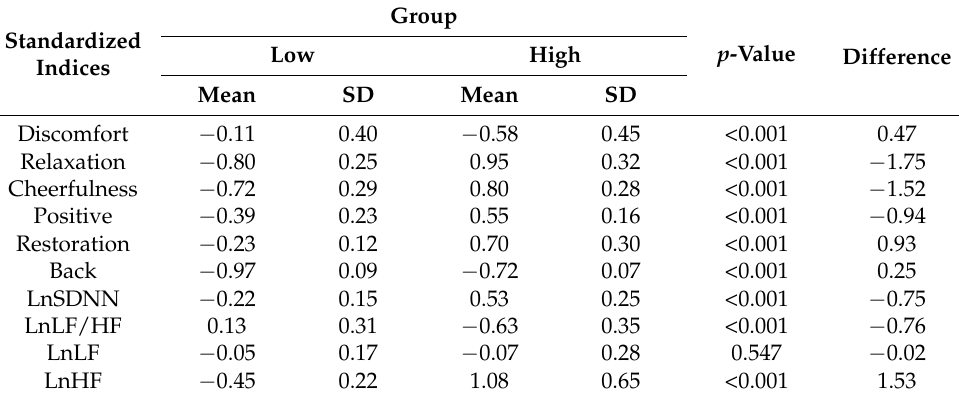
Table 1. Mean levels of the standardized values of Low and high Coping